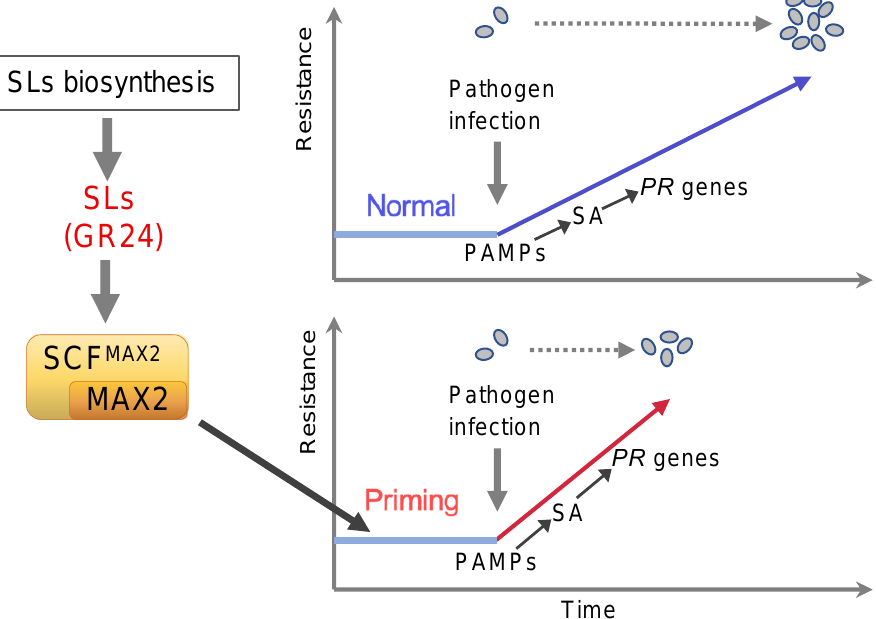
Figure 9. Proposed model for modulation mechanism of SA-mediated defense signaling by strigolactones. SCF MAX2 is SKP1-CUL1-F-box complex containing MAX2 as F-box protein.